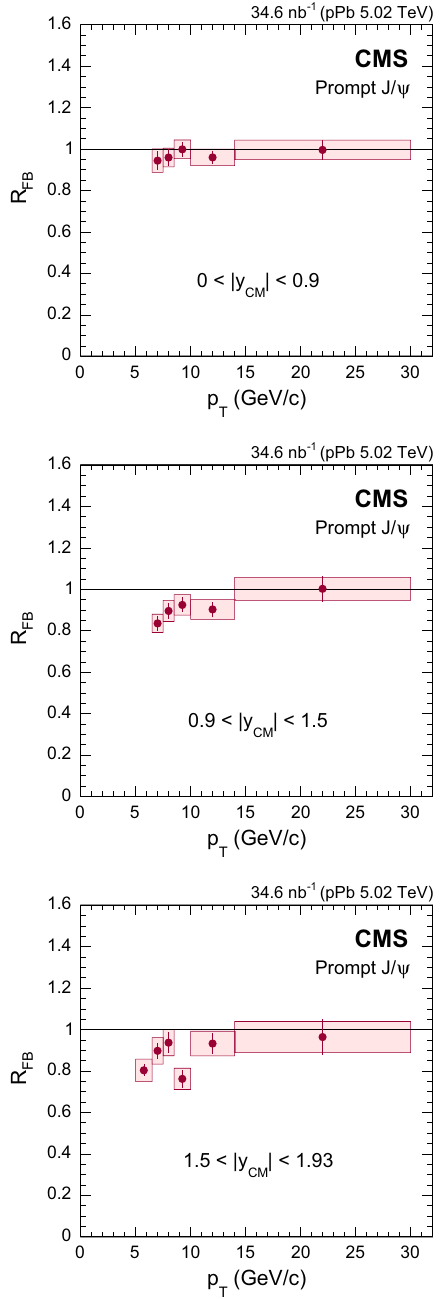
Fig. 6 Transverse momentum dependence of R FB for prompt J /ψ mesons in three y CM regions. The vertical bars represent the statistical uncertainties and the shaded boxes show the systematic